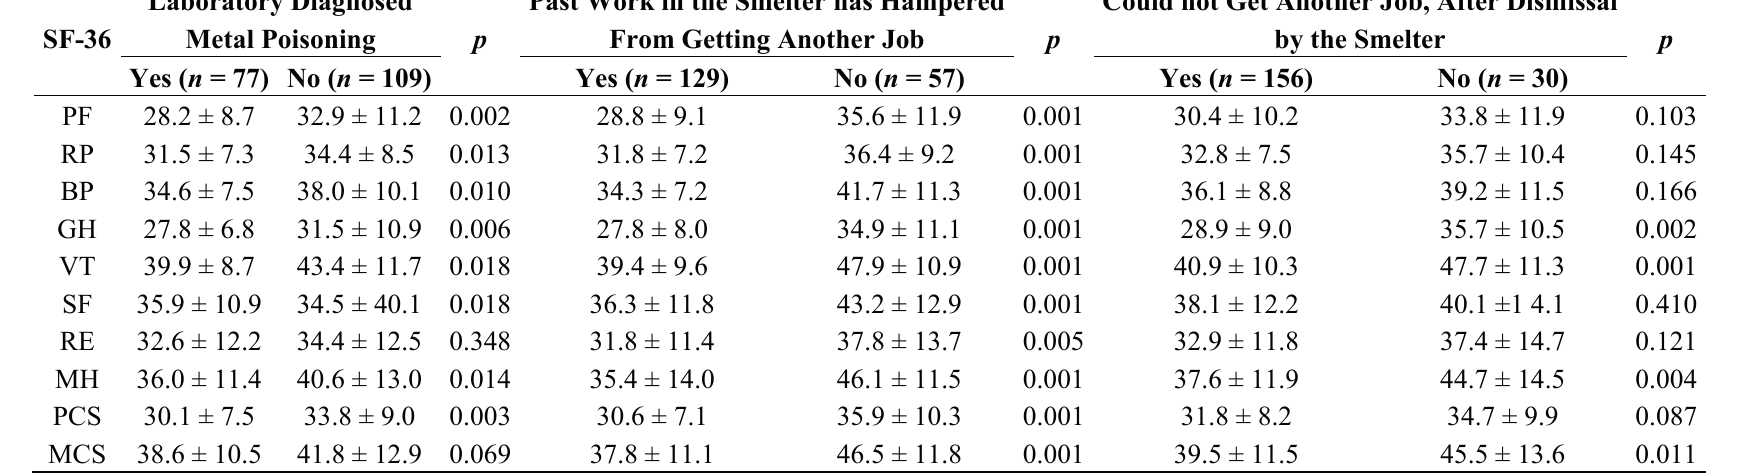
Table 3. SF-36 dimensions normalized scores (mean ± SD) in 186 former lead workers from Santo Amaro da Purificação lead smelter according to occupational history aspects, Brazil,